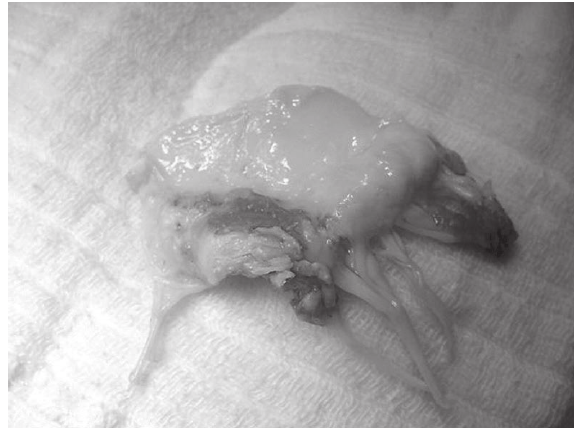
Fig. 1 - Cúspide anterior da valva mitral com